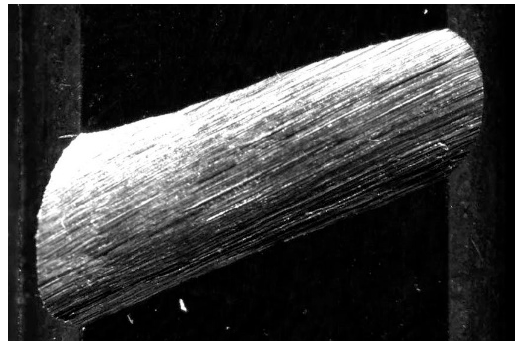
Figure 8. Image to be segmented.